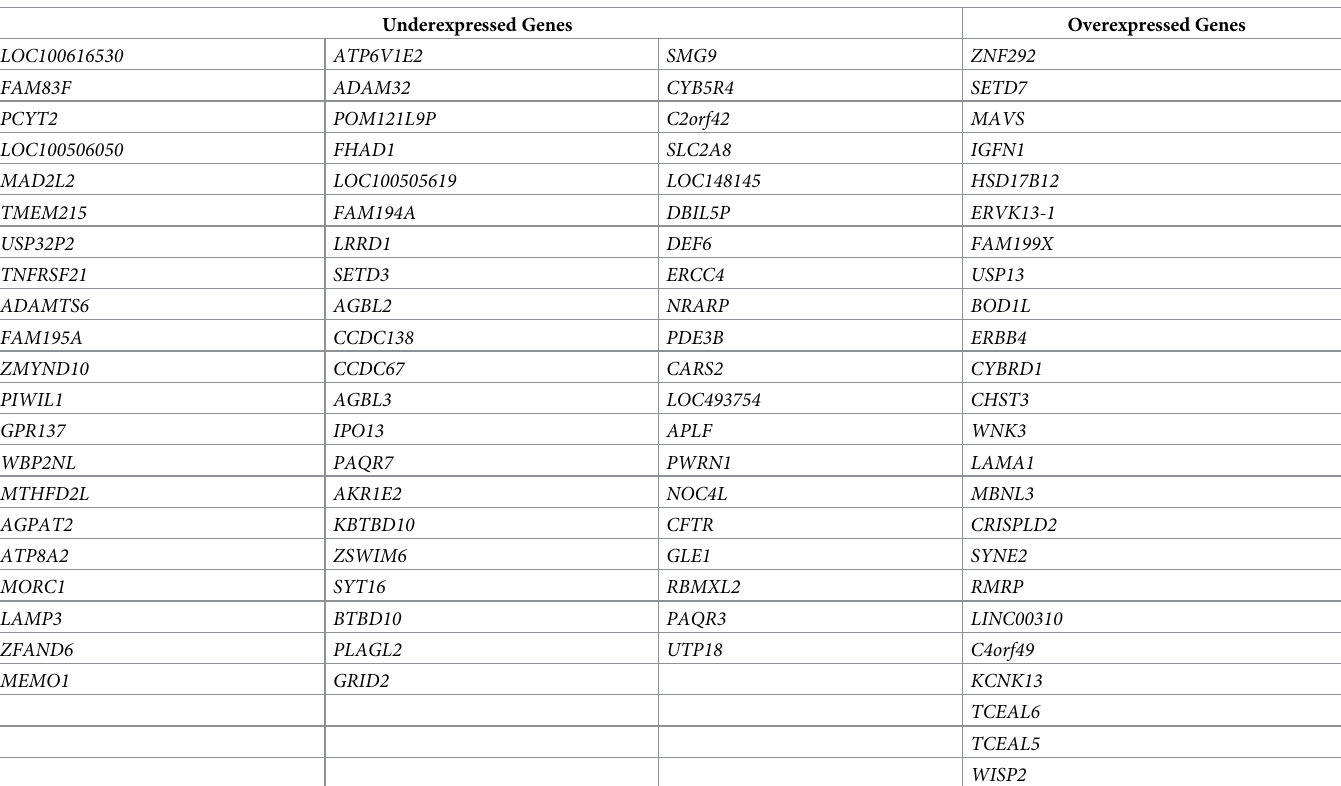
Table 4. Differentially expressed